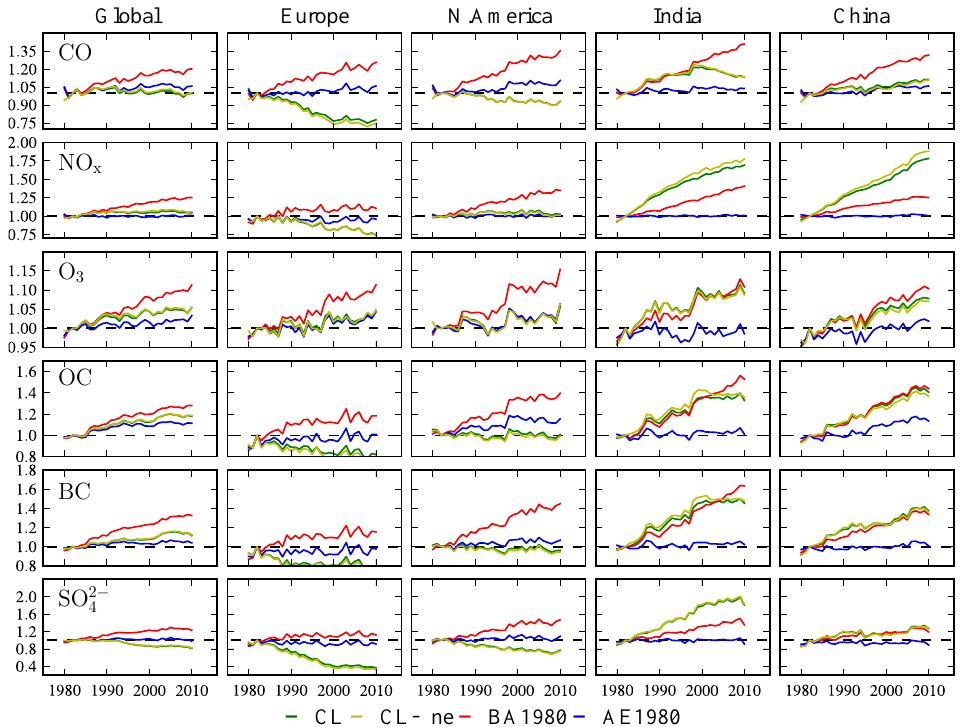
Figure 4. Annual mean surface concentrations for CO, NO x , O 3 , OC, BC, and sulfate aerosols (rows), averaged over the globe, Europe, North America, India, and China (columns) and normalized to the 1982 concentrations. The difference between the blue (AE1980) and green (CL) lines is the anticipated change in concentrations when assuming 1980 anthropogenic emissions at any given year, while the difference between the red (BA1980) and green (CL) lines is the calculated change in concentrations at any given year when taking into account the increased anthropogenic emissions due to the population growth. The yellow lines depict the annual mean surface concentrations of the CL-fine simulation. Note the difference in scales between